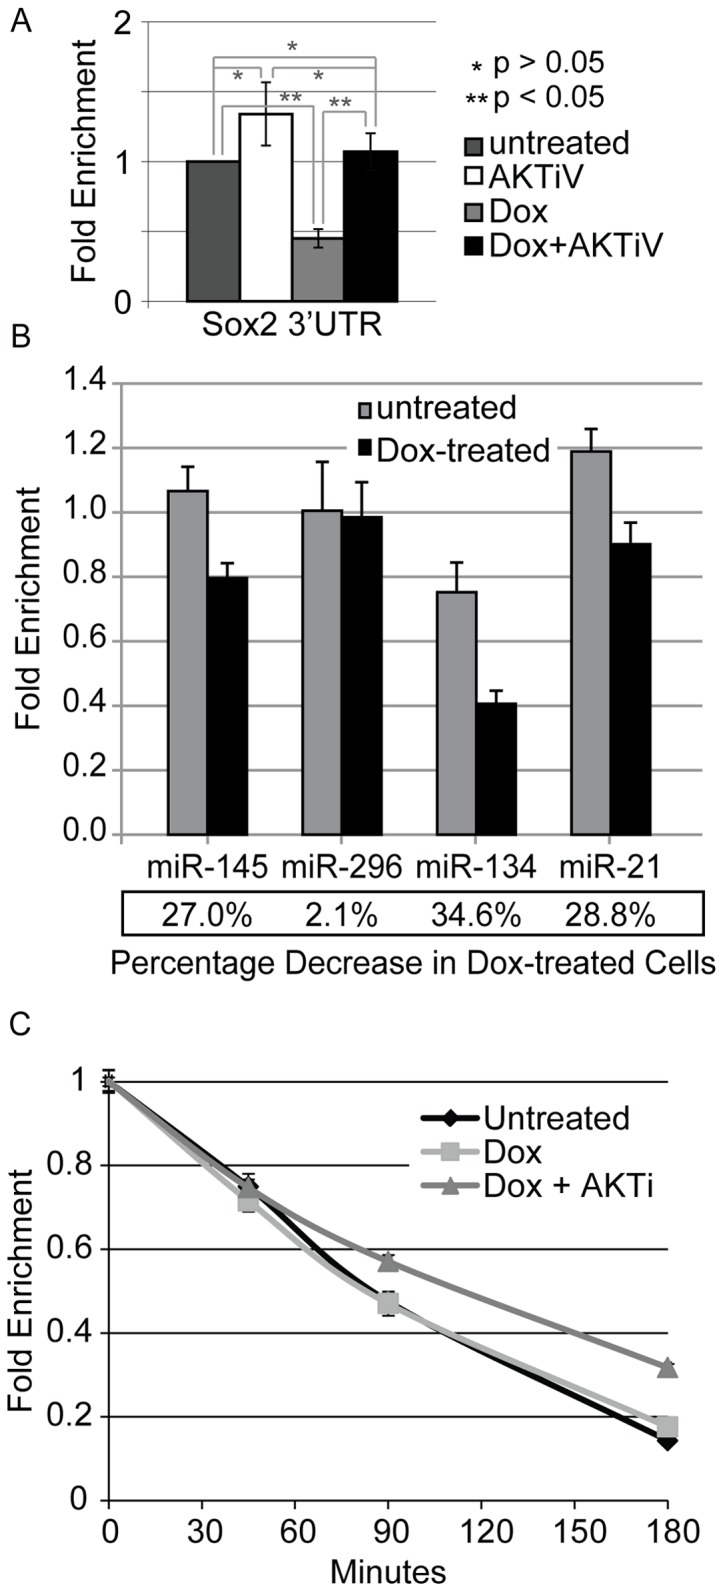
Changes in Sox2 mRNA and miRNA expression induced by increases in Sox2 protein.i-OSKM-ESC were seeded at 1.5×106 per 100 mm dish with or without 4 μg/ml Dox for 24 hours. (A) After the initial 24 hours, the cells were refed with fresh medium with or without 4 μg/ml Dox and/or 5 μM AKTiV for an additional 24 hours where indicated. 48 hours after the cells were plated, total RNA was isolated from the cells, and RT-qPCR was performed. A primer set specific to the untranslated region at the 3'-end (3'UTR), measuring endogenous Sox2 mRNA, was used in qPCR analysis performed in triplicate. Results are presented as the average fold change of mRNA expression, normalized to GAPDH expression, and compared to untreated i-OSKM-ESC. Statistical significance was determined by Student's t-test and indicated with asterisks: *p>0.05, **p<0.05. Detection of the Dox-inducible transgene expression may be underestimated due to possible limitations of the reverse transcription of the long poly-cistronic transcript that encodes for Oct4, Sox2, Klf4, and c-Myc. (B) After an initial 24 hours, i-OSKM-ESC were refed with fresh medium with or without 4 μg/ml Dox for an additional 24 hours, followed by isolation of total RNA. RT-qPCR using TaqMan probes was performed in triplicate to determine the expression of miR-145, miR-296, miR-134, and miR-21, normalized to RNU6B expression, and reported as average differences in fold change from RNU6B expression. (C) i-OSKM-ESC were seeded at 0.6×106 per 60 mm dish with or without Dox (4 μg/ml). After an initial 24 hours, the cells were refed with fresh medium with or without 4 μg/ml Dox and with 5 μM AKTiV for an additional 24 hours where indicated. RNA synthesis was blocked with 5 µg/ml actinomycin D and total RNA was isolated from the cells at 0, 45, 90, and 180 minutes after actinomycin D treatment (48 hours after plating). RT-qPCR was performed with a primer set specific to the untranslated region at the 3'-end (3'UTR) to measure the remaining endogenous Sox2 mRNA. Results are presented as the average fold change of mRNA expression, normalized to GAPDH expression, and shown as a percentage of remaining mRNA compared to the amount of mRNA present in each treatment before the addition of actinomycin D. Error bars represent standard error of the mean, n = 3. This experiment was repeated with longer periods of actinomycin D treatments and similar results were observed.